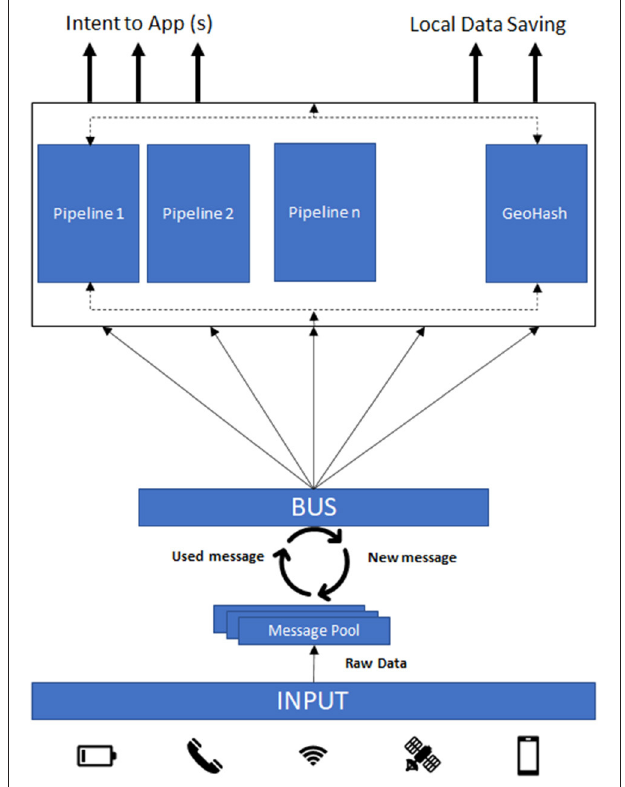
FIGURE 4 | MoST architecture.